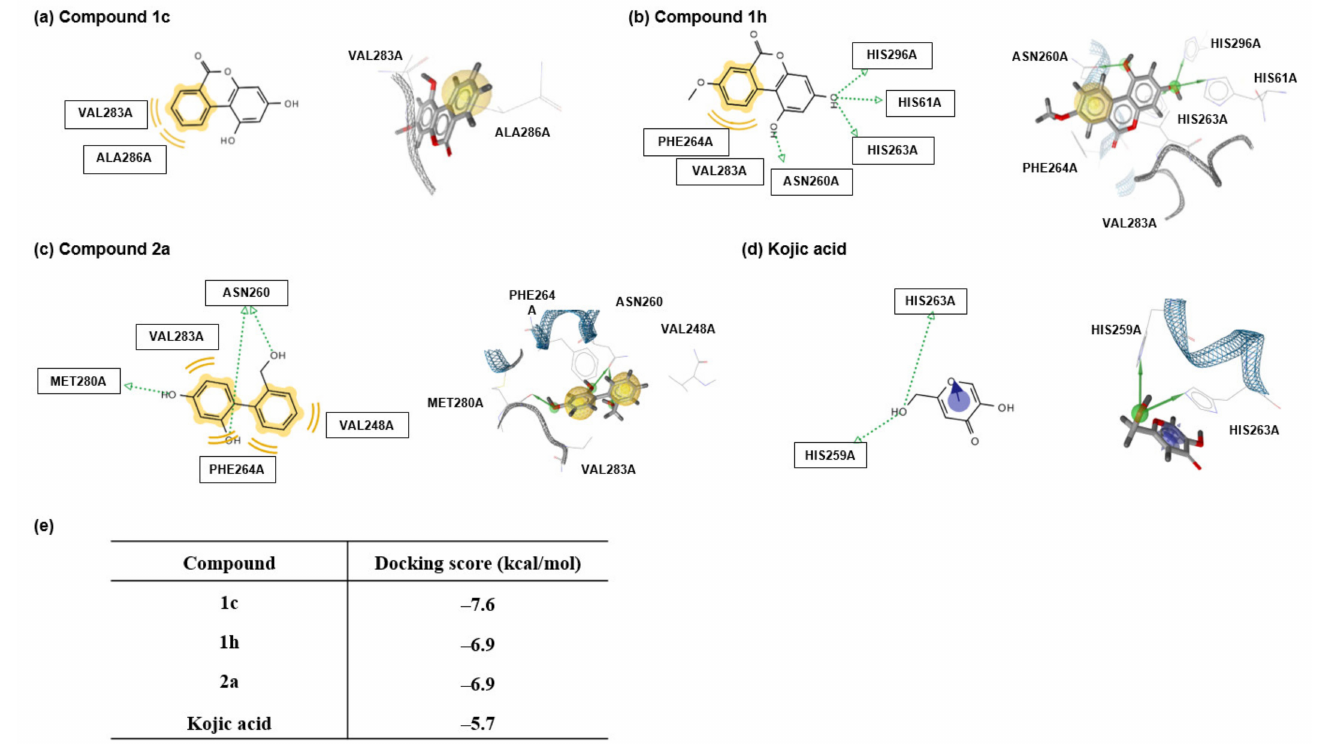
Figure 4. Docking simulation of urolithin derivatives 1c and 1h, o -phenylbenzyl alcohol derivative 2a, and kojic acid with Agaricus bisporus tyrosinase using AutoDock Vina and pharmacophore analysis. ( a – d ) Pharmacophore results of 1c, 1h, 2a, and kojic acid obtained using LigandScout 4.2.1 based on AutoDock Vina indicated possible hydrophobic, π - π stacking, and hydrogen bonding interactions between tyrosinase amino acid residues and the ligands (shown in yellow and indicated by violet and green arrows, respectively). Docking simulation results showed hydrophobic (yellow spheres), π - π stacking (violet ring), and hydrogen bonding (green spheres) regions on ligands. ( e ) Docking scores of 1c, 1h, 2a, and kojic acid with tyrosinase are tabulated (PDB code: